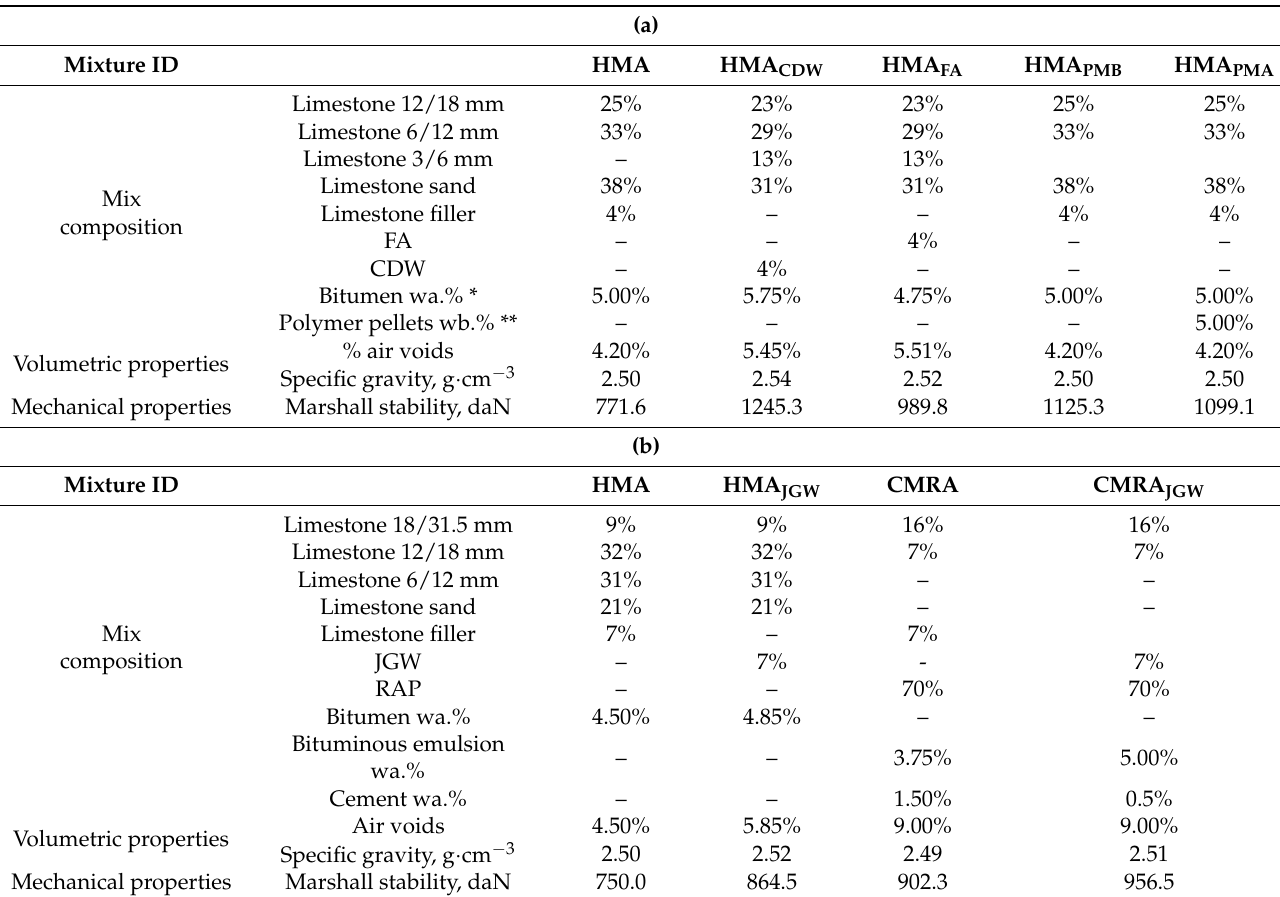
Table 4. Aggregate size distribution and mix design results for ( a ) the hot asphalt mixtures for the binder layer and ( b ) the cold asphalt mixtures for the base